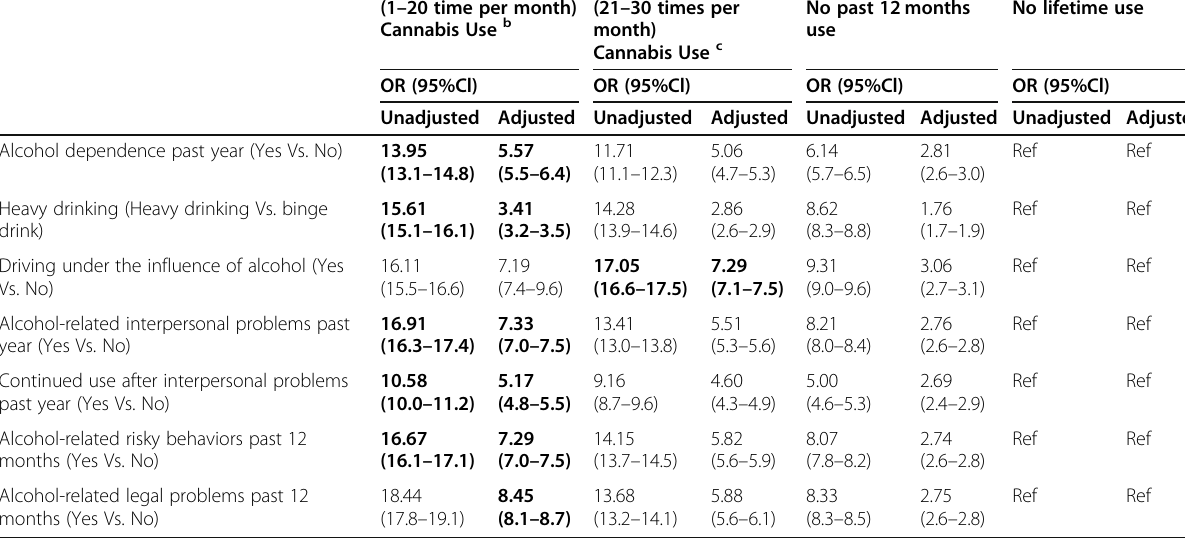
Table 3 Multiple logistic regressions estimating association of Cannabis Use with alcohol-associated adverse effects (Unadjusted/ Adjusted)